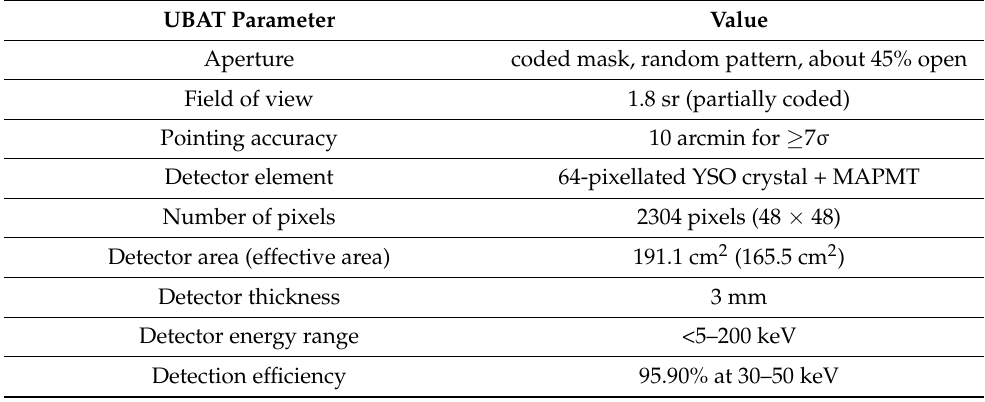
Table 1. Specifications of the UFFO Burst Alert and Trigger telescope (UBAT).